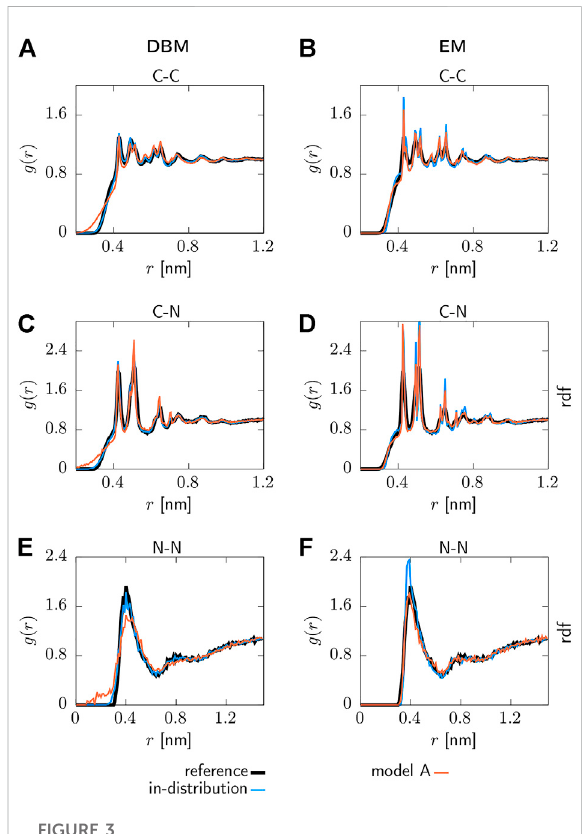
FIGURE 3 Pair correlation functions g ( r ) for the AA reference system, backmapped in-distribution test set and backmapped test set for CG model 1. Results obtained with DBM (left) and EM scheme (right) are displayed, including non-bonded (A,B) C-C, (C,D) C-N and (E,F) N-N correlations.